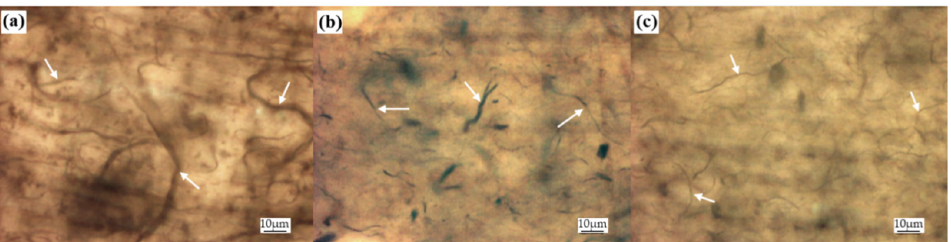
Figure 8. Magnification microscope 50× images revealing CNT bundles, indicated by white arrows, in nanocomposites created from: ( a ) untreated CNT pulp; ( b ) 2.5 h activated CNT pulp; ( c ) Eu:Y 2 O 3 -CNTs.